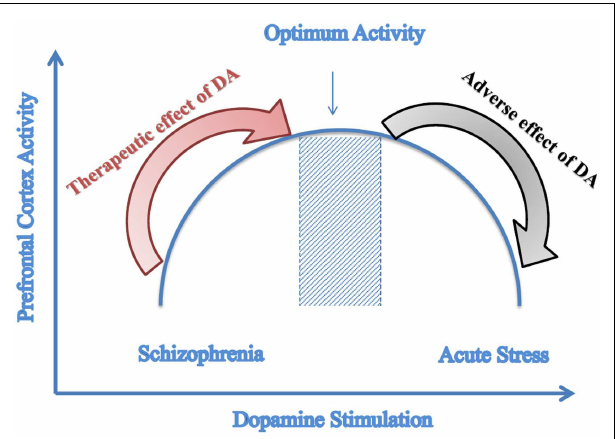
FIGURE 3 | Predictive model of dopamine stimulation. Inverted-U graph of prefrontal cortex function depending on the level of dopamine stimulation; Dopamine agonists have a therapeutic effect on Schizophrenia that is a state of reduced dopamine stimulation while these agonists cause adverse effects to controls who have optimal dopamine stimulation. (Adapted with modifications from Komek et al., 2012).